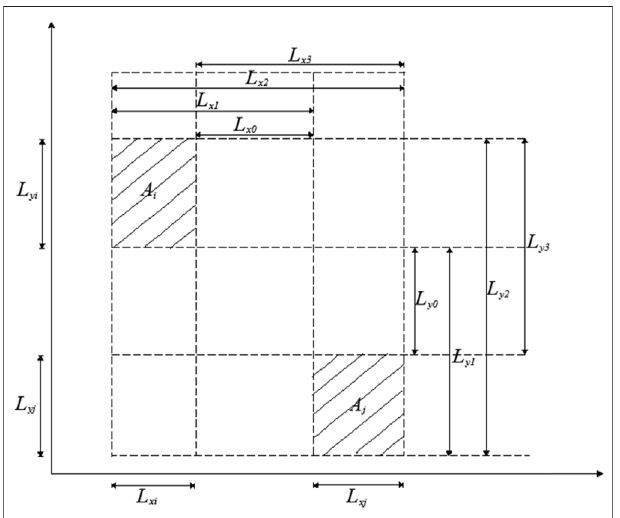
FIGURE 3 | Local average random fi elds.